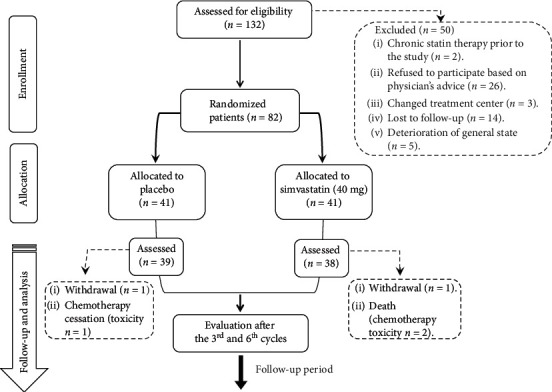
CONSORT flow chart.